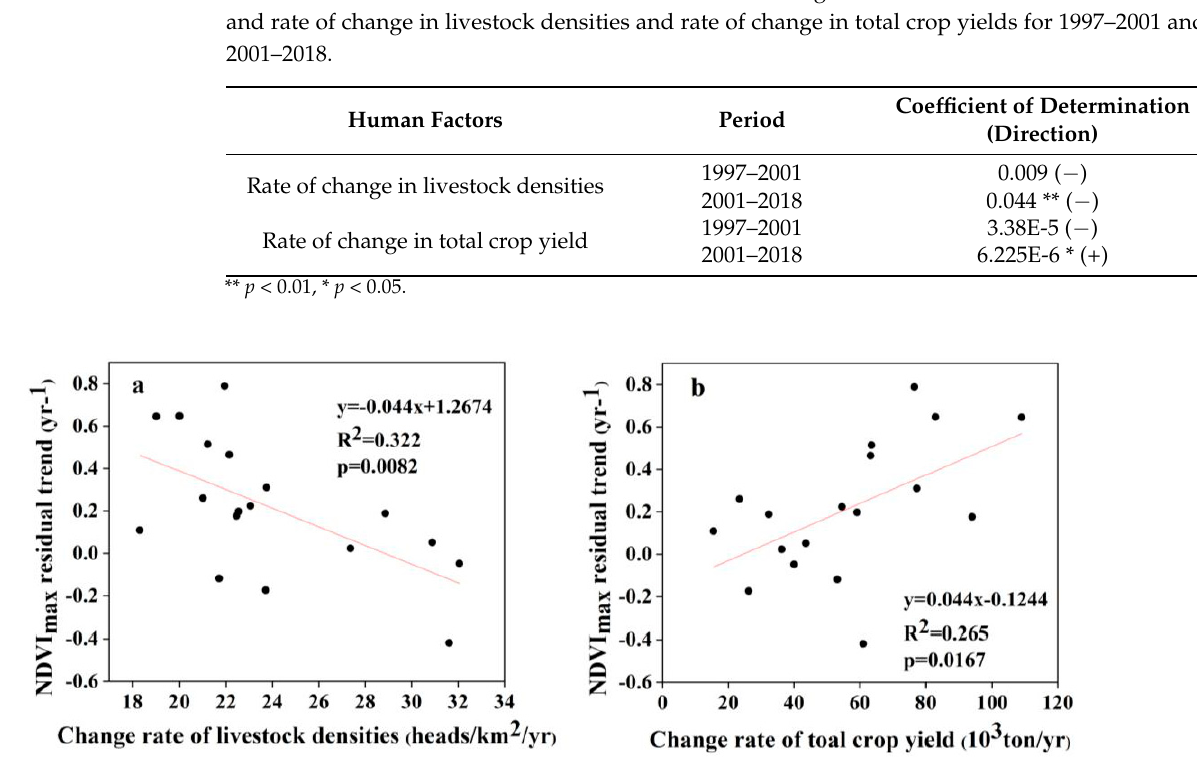
Figure 11. Relationships between NDVI residual trend and change rates: ( a ) for livestock densities from 2001 to 2018; and ( b ) for total crop yields from 2001 to 2018.